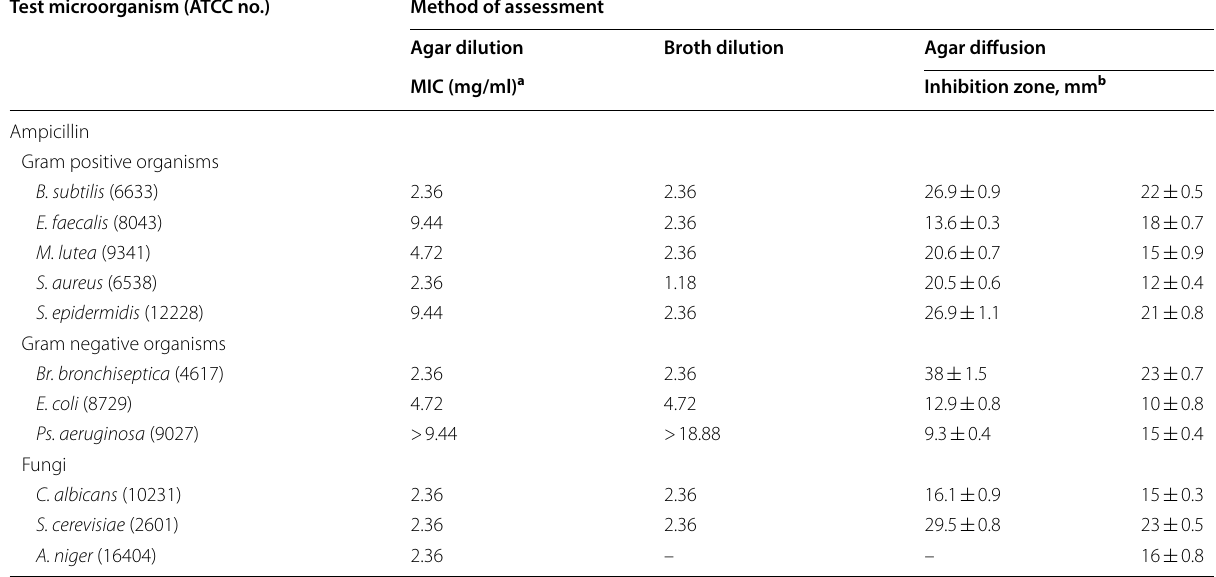
a Minimum Inhibitory concentration, average of three determinations b Average of 10 readings